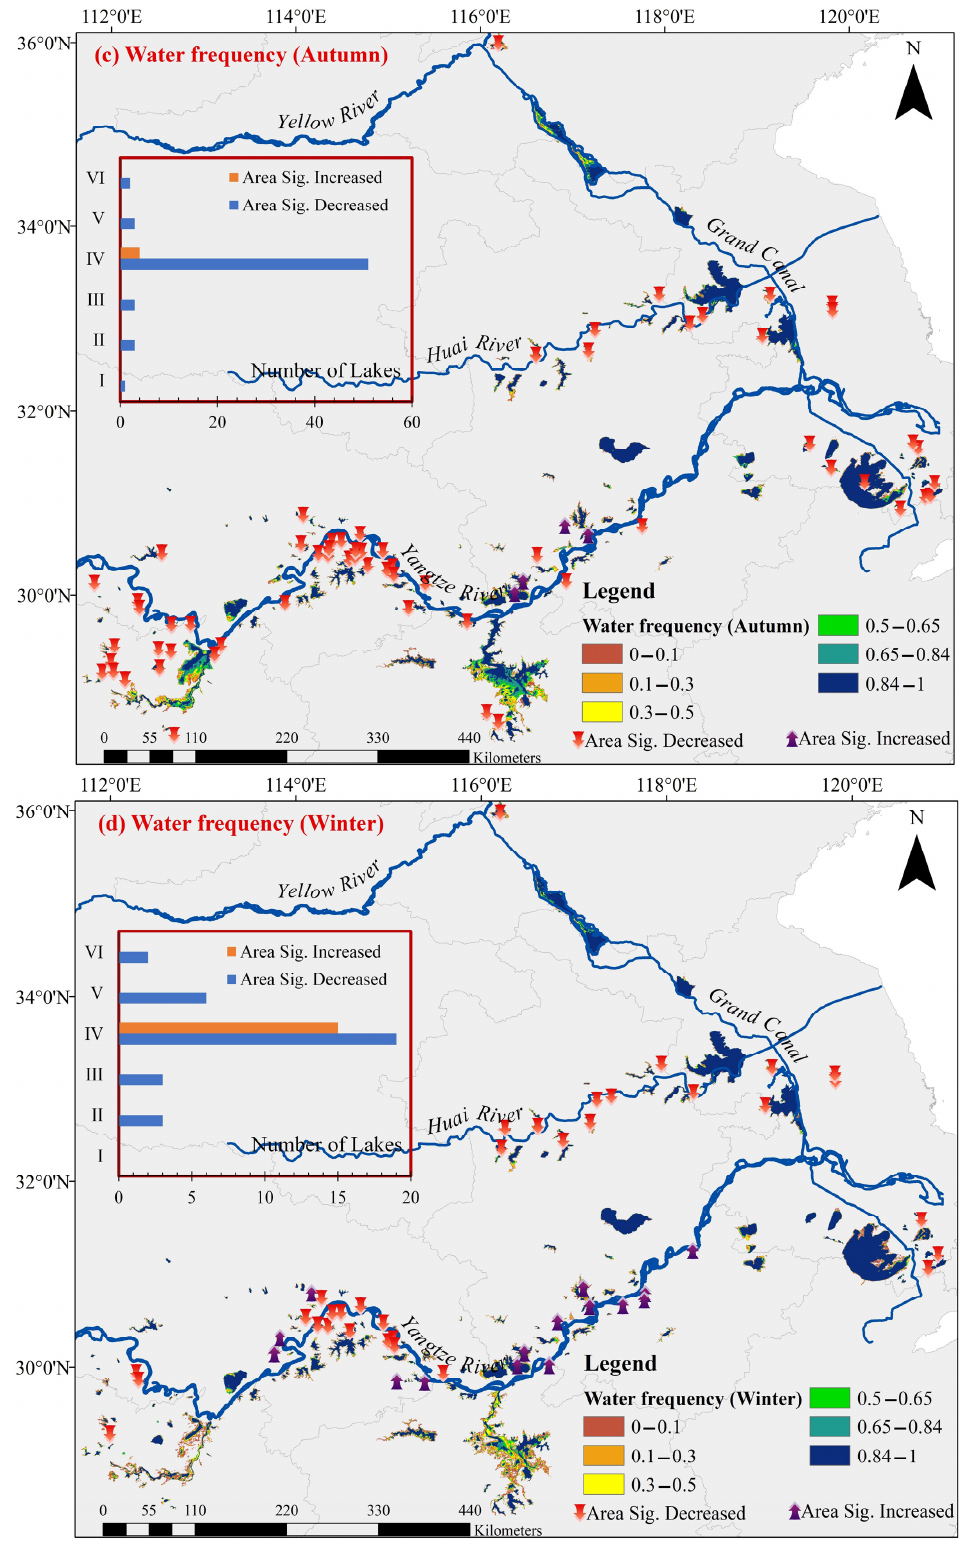
Figure 8. Seasonal water frequency of the study lakes in the EPL. Seasonal lake area significantly ( p < 0.05) increased or decreased, denoted with the symbol “ ↑ ” or “ ↓ ”, respectively. Water frequencies were calculated for each meteorological season: ( a ) spring, ( b ) summer, ( c ) autumn, and ( d ) winter. The annual water frequency map is shown in Figure 1, and the annual lake inunda- tion area also exhibited significant increases or decreases ( p < 0.05). The annual water frequencies were also classified into six levels: 0–0.1, 0.1–0.3, 0.3–0.5, 0.5–0.65, 0.65–0.84, and 0.84–1, accounting for 27.23%, 15.35%, 10.50%, 7.31%, 11.26%, and 28.36%, respec- tively. The center of each lake exhibited a higher frequency than the edge. In addition, 13.59% (25/184) of the lakes exhibited significantly decreasing trends during the obser- vation period of 21 years, while 25% (46/184) of the lakes experienced a significantly in- creasing trend. As shown in Tables 3 and S1, the annual area of A002 (Poyang Lake) showed the largest rate of decrease ( − 29.09 km 2 year - , 1 r = − 0.5, p < 0.05) during 2000– 2020, among all 184 study lakes, while the lake D30 (Huangdahu) experienced the larg- est rate of increase (5.94 km 2 year - , 1 r = 0.49, p < 0.05). Among the lakes located down- stream of Poyang Lake, 24.73% (23/93) and 11.83% (11/93) exhibited significant ( p < 0.05) increases and decreases, accounting for 50% (23/46) and 44% (11/25) of all lakes with sig- nificantly ( p < 0.05) increasing and decreasing trends, respectively.